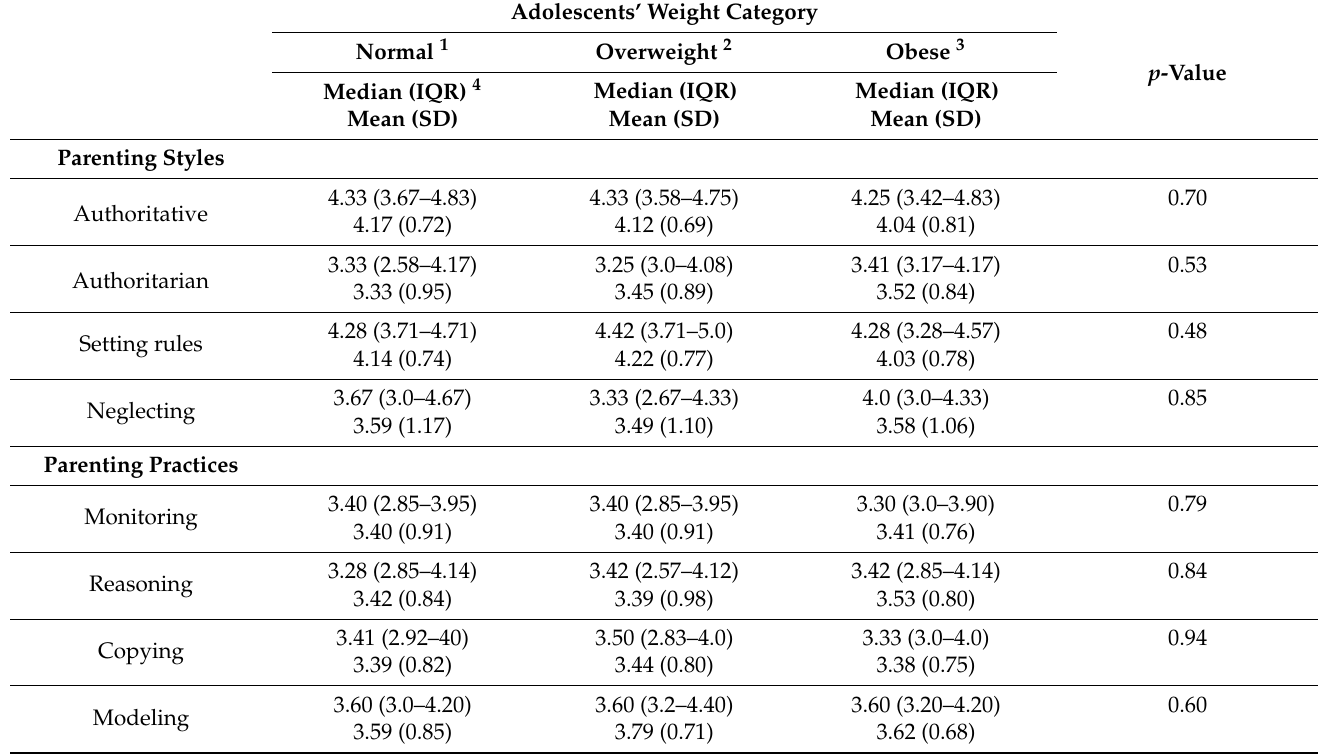
Table 6. Correlation between the categorized BMI percentiles of the adolescents and parenting styles and food parenting practices.